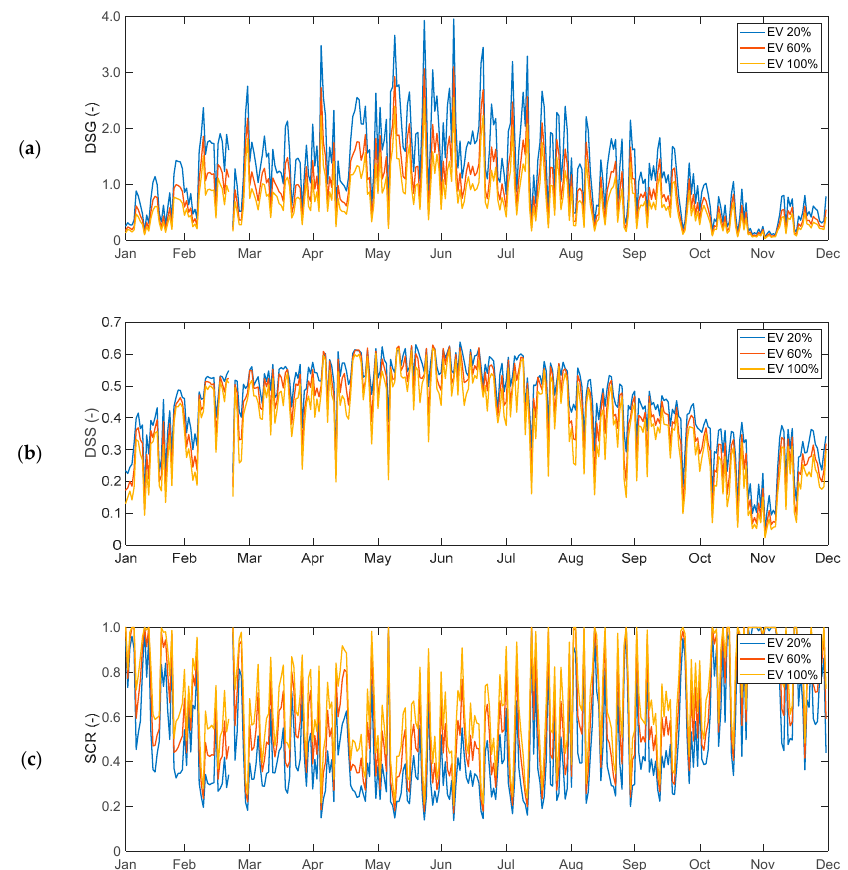
Figure 23. Key performance indicator of cell 13 for the simulation period of one year and for a fixed penetration of 60% PV and a variation of the penetration of EV for 3.7 kW charging power and charging strategy 1 ( a ) DSG ( b ) DSS ( c ) SCR.